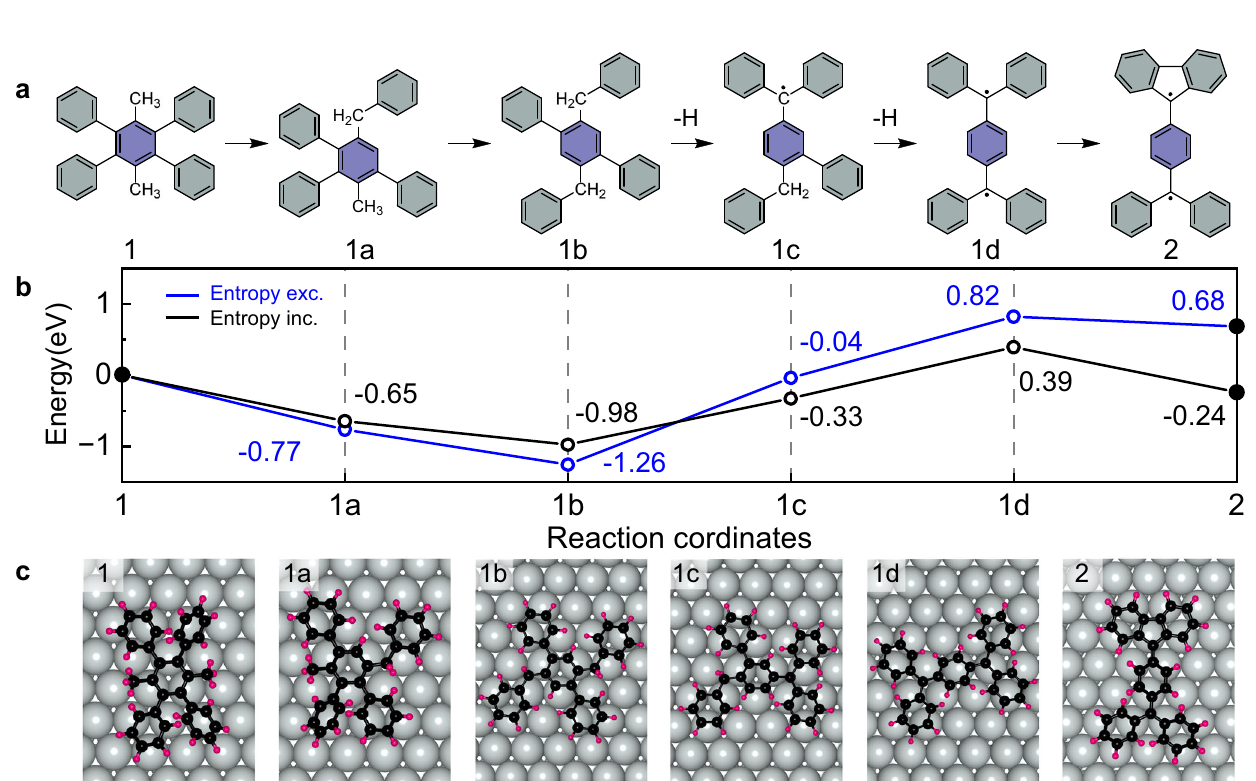
Fig. 3 | Proposed reaction pathway of the phenyl migration reaction. a Proposed reaction pathway of the structural rearrangement of precursor 1 to form phenyl-migrated product 2 via a dehydrogenative-induced detachment and migration of phenyl groups. Shaded rings with two different colors mark the four